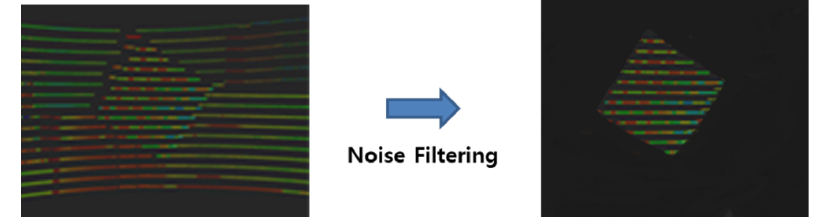
Figure 10. Noise filtering for 3D LiDAR data of interests.